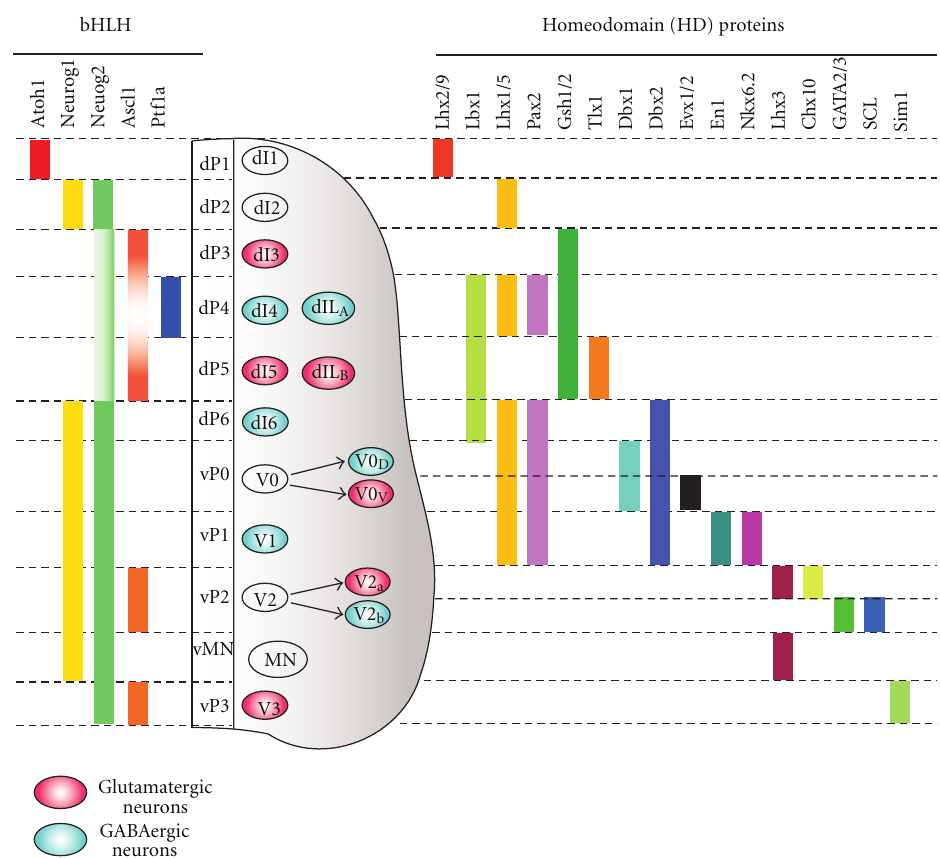
Figure 1: The specification of the spinal cord neurons directed by a combinatorial code of transcription factors. Schematic summary of the expression of bHLH transcription factors in the progenitor cells (left) and homeodomain (HD) transcription factors in the di ff erentiating and di ff erentiated neurons. Eleven early classes of postmitotic neurons (dI1 ∼ 6, V0 ∼ 3, and motoneurons (MN)) and two late-born dorsal interneurons (dIL A and dIL B ) are present in the embryonic spinal cord. The immature postmitotic V0 and V2 interneurons are further subdivided into two distinct interneuron subtypes indicated by arrows. The glutamatergic excitatory neurons and GABAergic inhibitory neurons are represented by red and blue circles,